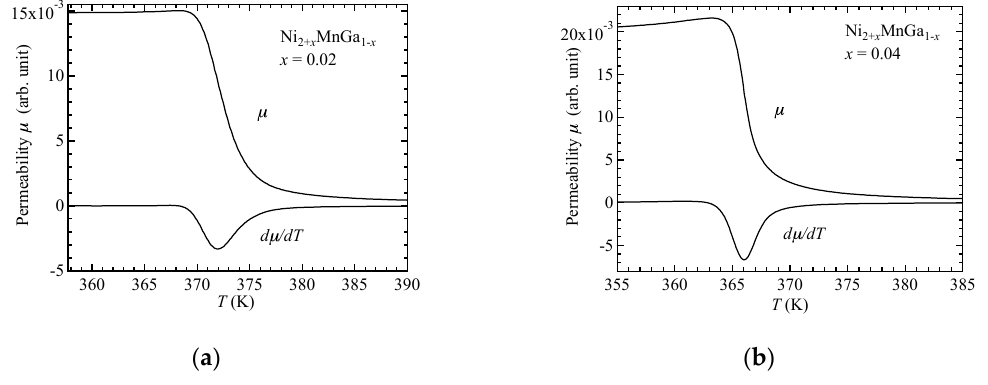
Figure 1. Plots of µ vs. T and d µ / dT vs. T for ( a ) x = 0.02 and ( b ) x = Figure 1. Plots of μ vs. T and d μ / dT vs. T for ( a ) x = 0.02 and ( b ) x = 0.04.